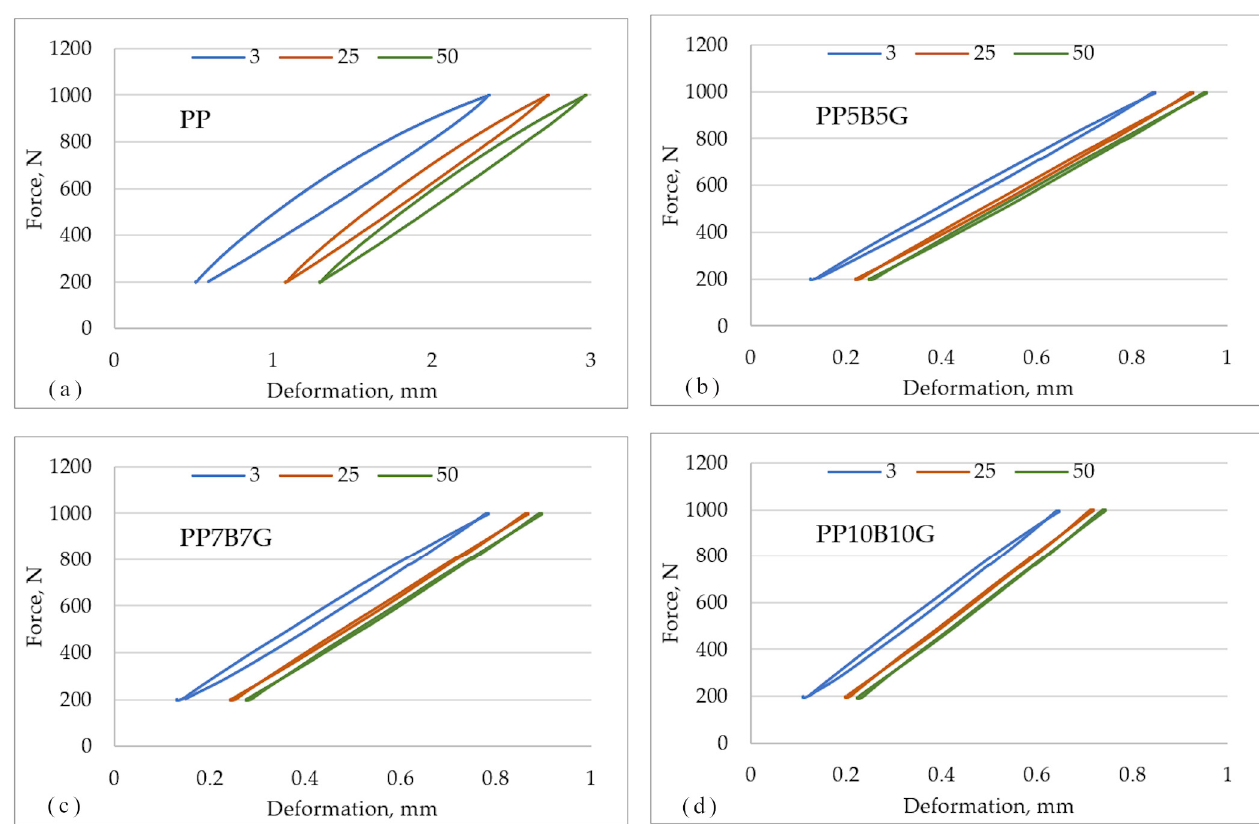
Figure 9. Hysteresis loops of the tested materials. ( a ) PP, ( b ) PP5B5G, ( c ) PP7B7G, ( d ) PP10B10G.